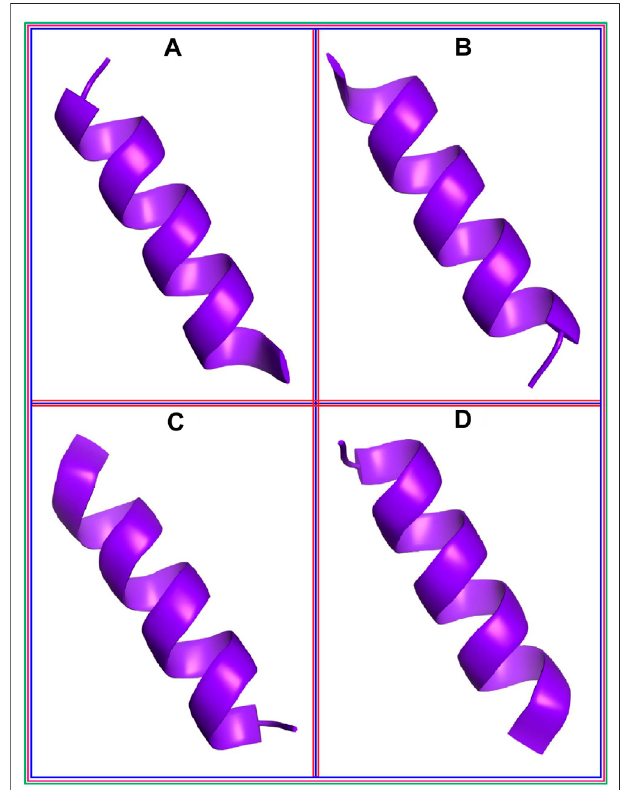
FIGURE 1 | The best four peptide molecules based on the binding free energyinthe docking program; (A) P2, (B) P18, (C) P20, and (D) P21peptide